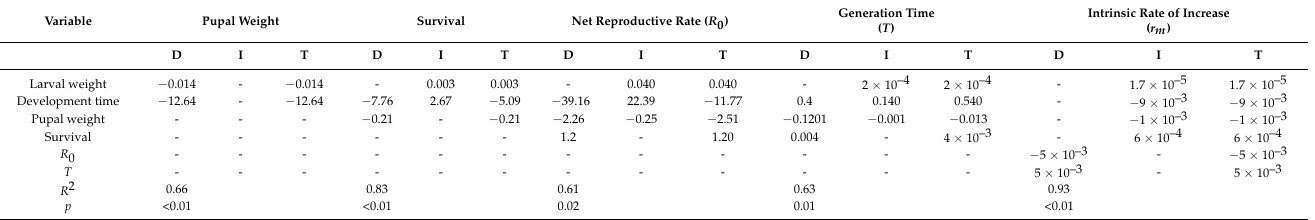
Figure 7. Path analysis diagram of the influence of Bt-toxin-free environment (i.e., maize, cotton, and soybean foliage) on life-history traits and population fitness of fall armyworm populations showing differential resistance to Cry1A.105+Cry2Ab2 Bt toxins. The result of χ 2 goodness-of-fit for the path model is indicated. One-headed arrows indicate causal relationships (regression), while doubled-headed arrows indicate the correlation between the variables. Asterisks represent significance levels (** p < 0.01), and the thickness of each line is proportional to the strength of the relationship. Solid arrows indicate positive relationships, while dashed arrows indicate negative relationships. Direct, indirect, and total values for path coefficients are shown in Table 3. Table 3. Direct (D), indirect (I), and total (T) effects in the path diagram of Figure 7 for the model on the influence of resistance to Cry1A.105+Cry2Ab2 on life-history traits and their potential consequences for population growth of the fall armyworm.